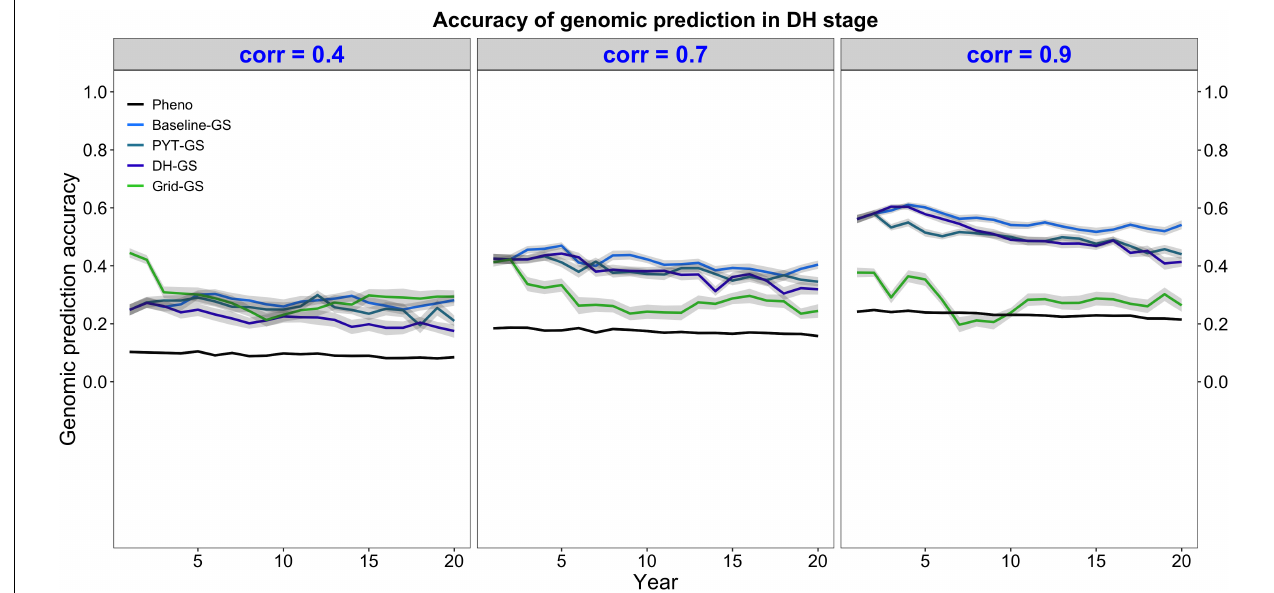
FIGURE 5 | Genomic prediction accuracy over time for five simulated breeding programs. Results are shown under genetic correlations of 0.4, 0.7, and 0.9. Simulations are based on a medium annual operating budget (approx. United States $500K). Genomic prediction accuracy is plotted as mean genomic-predicted general intercropping ability in the doubled haploid stage for the entire future breeding phase. The lines within each of the three panels represent the five breeding programs where each line represents mean genomic-predicted general intercropping ability for the 30 simulated replicates and the shadings show standard error bands. The black line represents the Phenotypic selection breeding program (Pheno), the blue-colored lines represent the three Conventional genomic selection breeding programs (Baseline-GS, the Baseline genomic selection breeding program; PYT-GS, the Preliminary yield trial genomic selection breeding program; DH-GS, the Doubled haploid genomic selection breeding program) and the green-colored line represents the Grid genomic selection breeding program